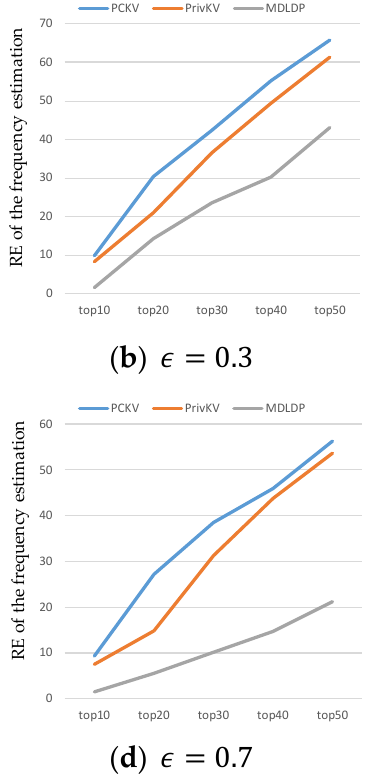
15 of 17 ( a ) MSE of frequency estimation with 𝜖 ( b ) MSE of mean estimation with 𝜖 Figure 10. MSE of the frequency estimation and mean estimation with different ϵ .